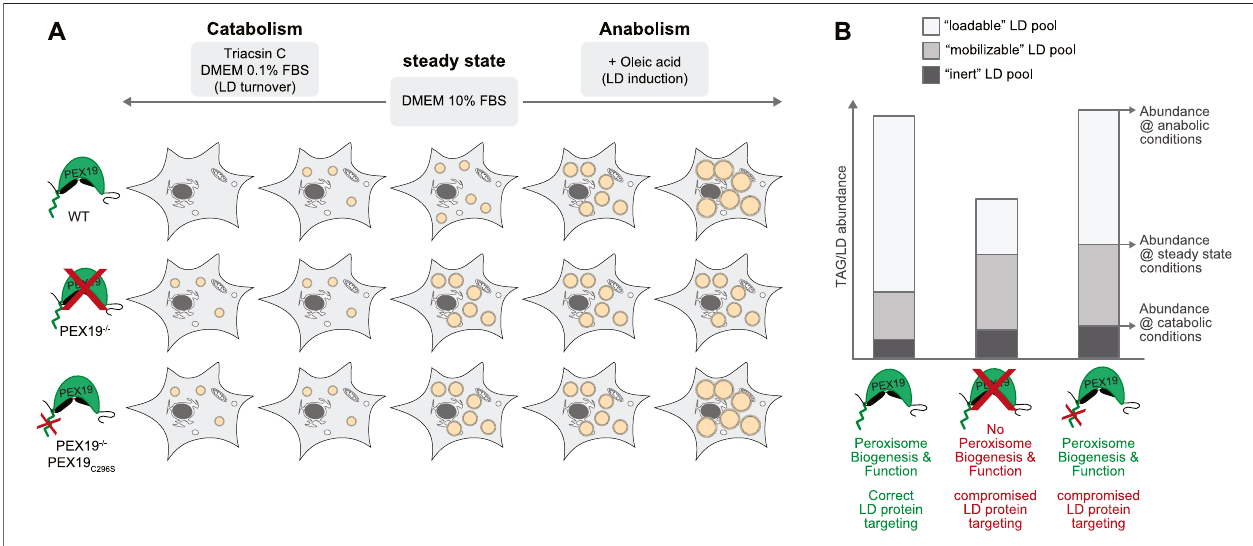
FIGURE 7 | Working model for the in fl uence of PEX19 on neutral lipid storage and consumption. (A) Schematic representation of the results obtained regarding TAG storage in LDs under different metabolic conditions. Abundance of LDs in wild-type (WT), PEX19 − / − and PEX19 − / − PEX19 C296S cells under normal steady state growth conditions, under catabolic or under anabolic growth conditions is exempli fi ed by orange circular structures. (B) Absolute abundance of TAG levels under catabolicgrowthconditions,undernormalgrowthconditionsandunderanabolicconditionsareindicatedtoscaleinastacked-bardiagramandre fl ect “ inert ” (dark grey), “ mobilizable ” (medium grey) and “ loadable ” (light grey) LD pools, respectively. Characteristics of WT, PEX19 − / − and PEX19 − / − PEX19 C296S cells regarding peroxisome biogenesis and function as well as protein targeting to LDs are indicated. For further explanations see text.